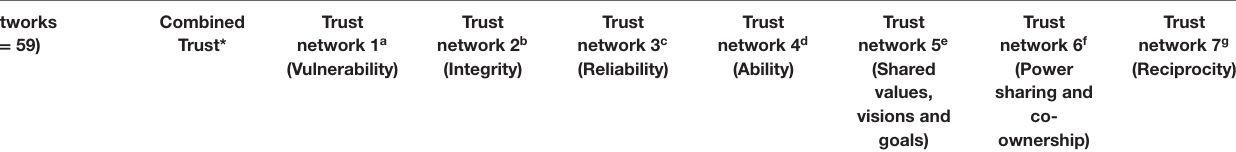
TABLE 2 | Pearson correlations for trust